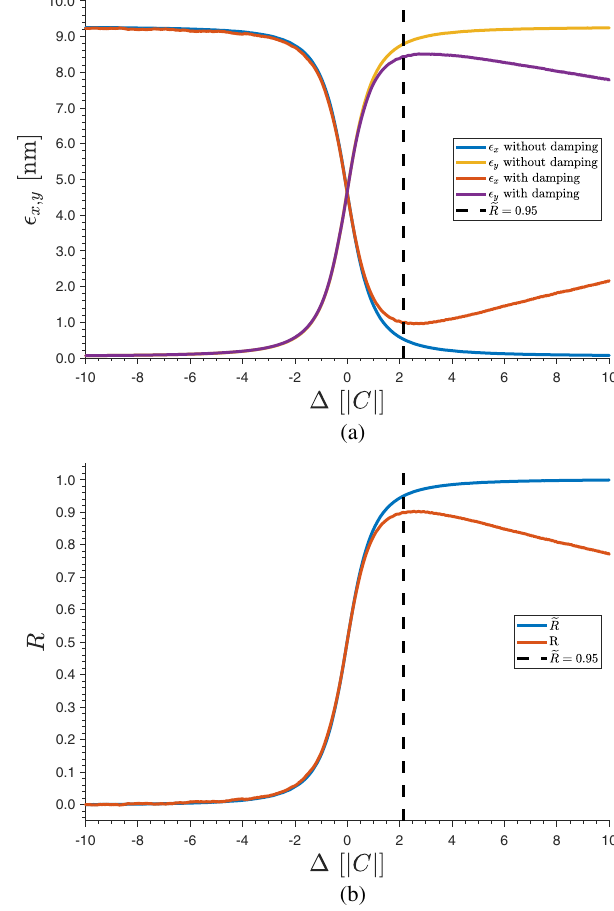
FIG. 5. Simulated effect of radiation on the emittance exchange process. After the resonance crossing ( Δ > 0 ) the emittances are out of equilibrium, and the radiation damping and quantum excitations will attempt to restore the equilibrium. The dotted line ˜ R ¼ 0 shows the point when . 95 for the undamped case, which is when Δ ¼ 2 . 1 j C j . The simulation is made using the SLS booster lattice using 3400 turns with damping times of 12 . 7 × 10 3 turns and 20 . 6 × 10 3 turns in the horizontal and vertical plane, respectively, and S ¼ 0 . 5 and j C j ¼ 0 . 01